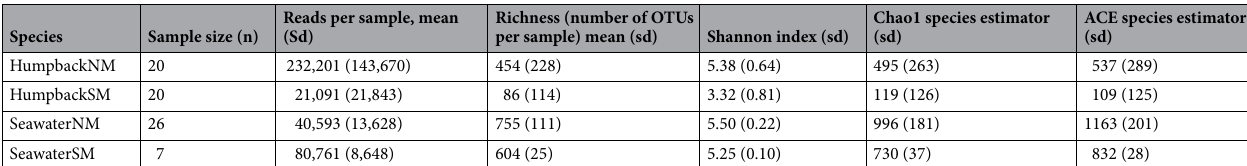
Table 1. Number of reads and alpha diversity parameters (samples size, richness, Shannon index, Chao1 and ACE) of rarefied data (rarefied number of reads = 3432) of samples of 20 humpback whale (HumpbackNM) and 26 seawater (SeawaterNM) samples at the beginning of their fasting and of 20 humpback whale (HumpbackSM) and 7 seawater (SeawaterSM) samples at a later stage. Numbers are after deleting putative technical contaminant zOTUs from the